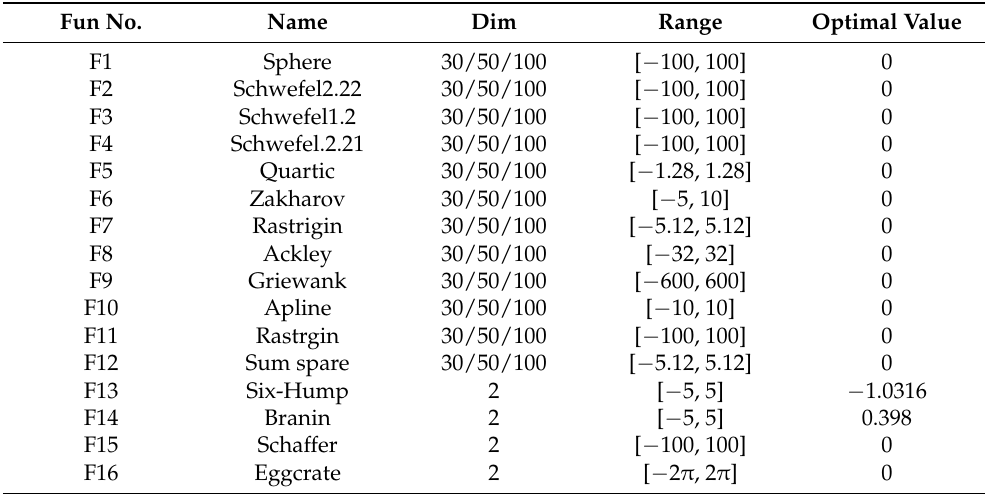
Table 1. The benchmark test functions.